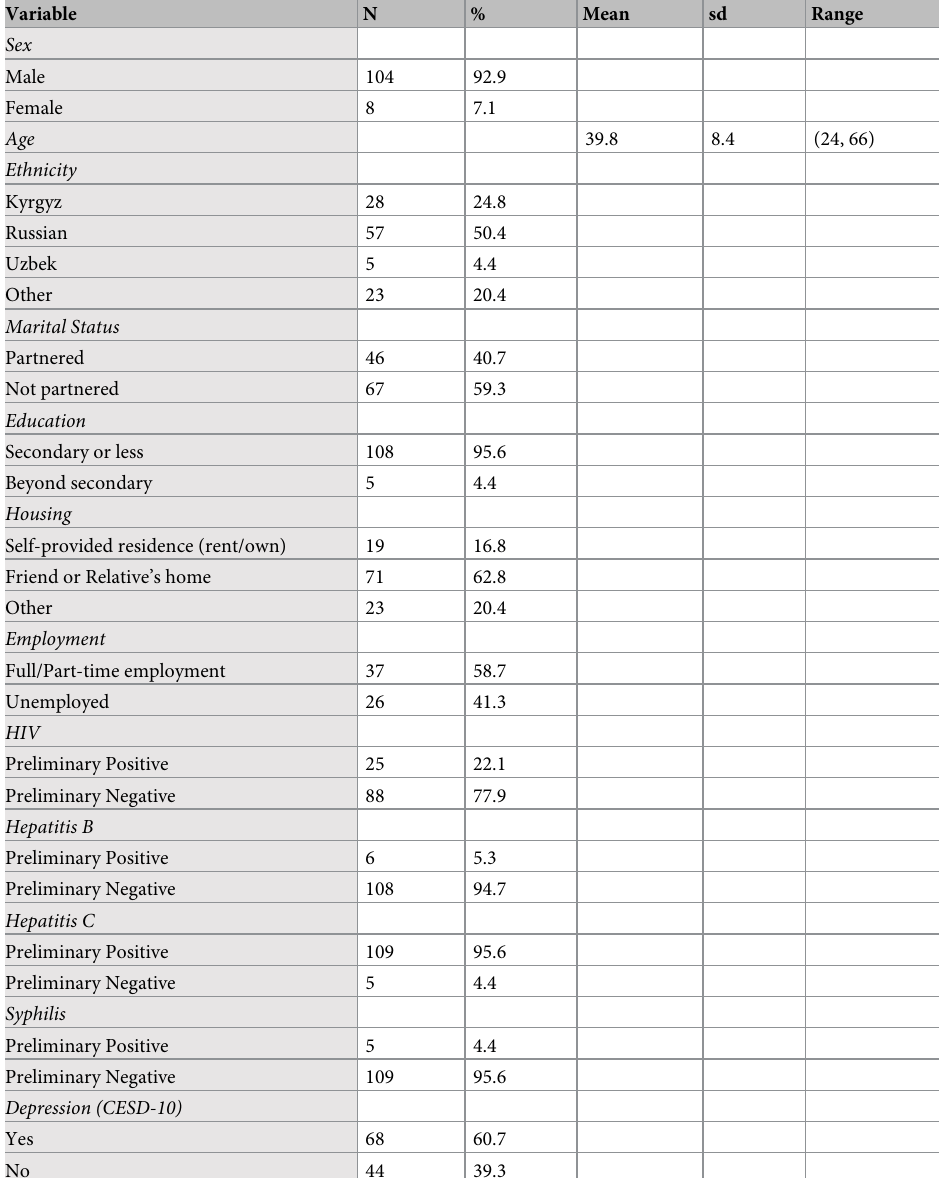
Table 1. Survey participant